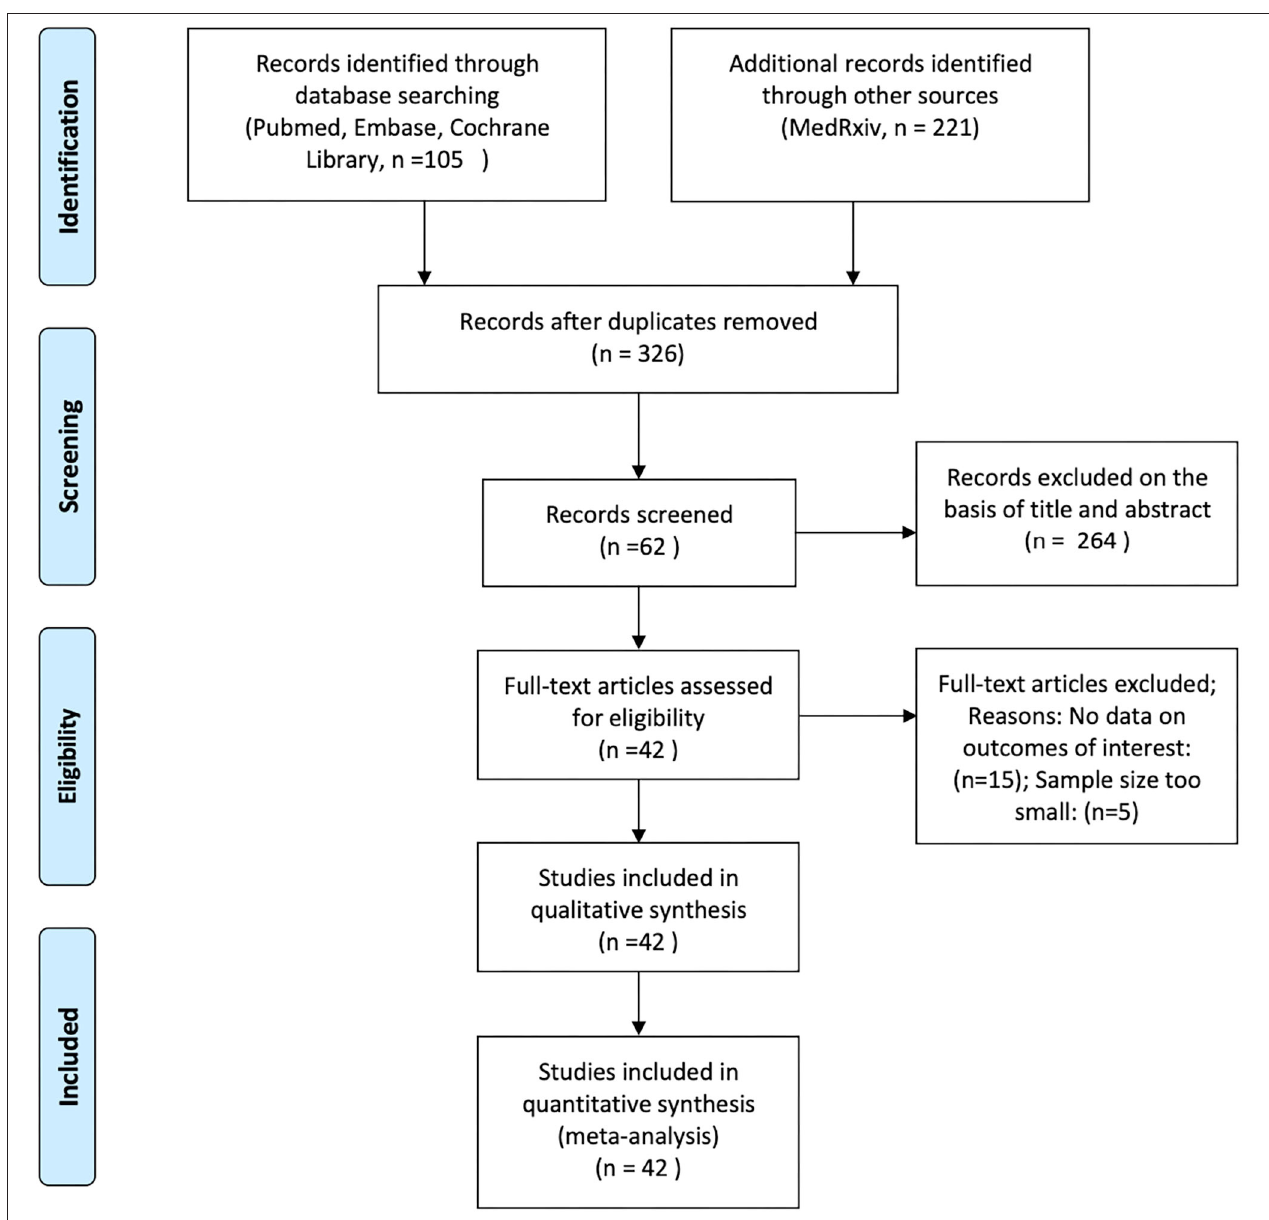
FIGURE 1 | Flowchart of article selection process.